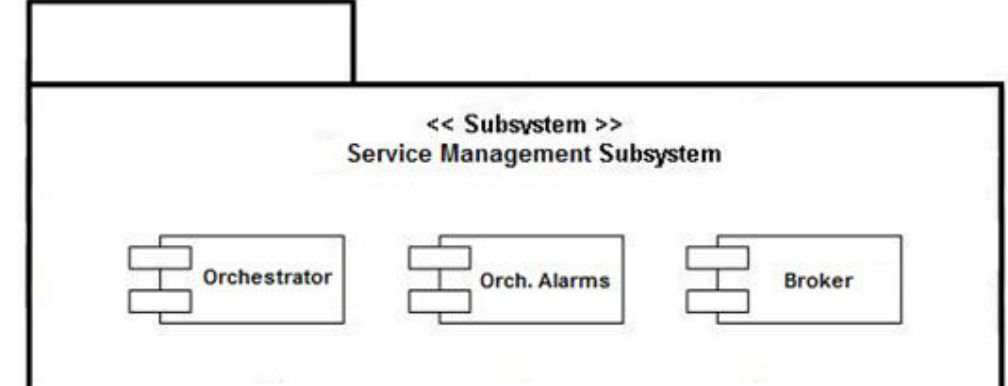
Figure 13. Service Management subsystem and its inner